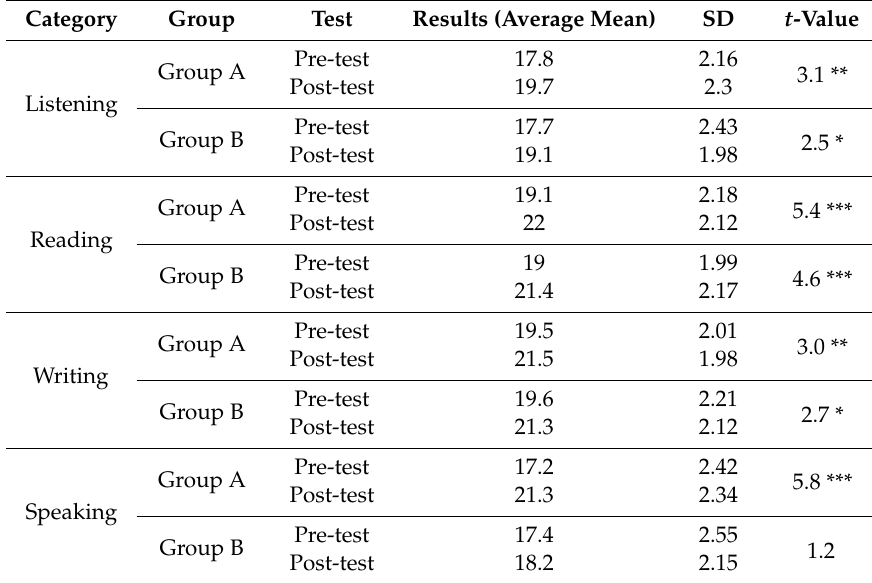
Table 1. Descriptive statistics (results of pre-test and post-test on English).